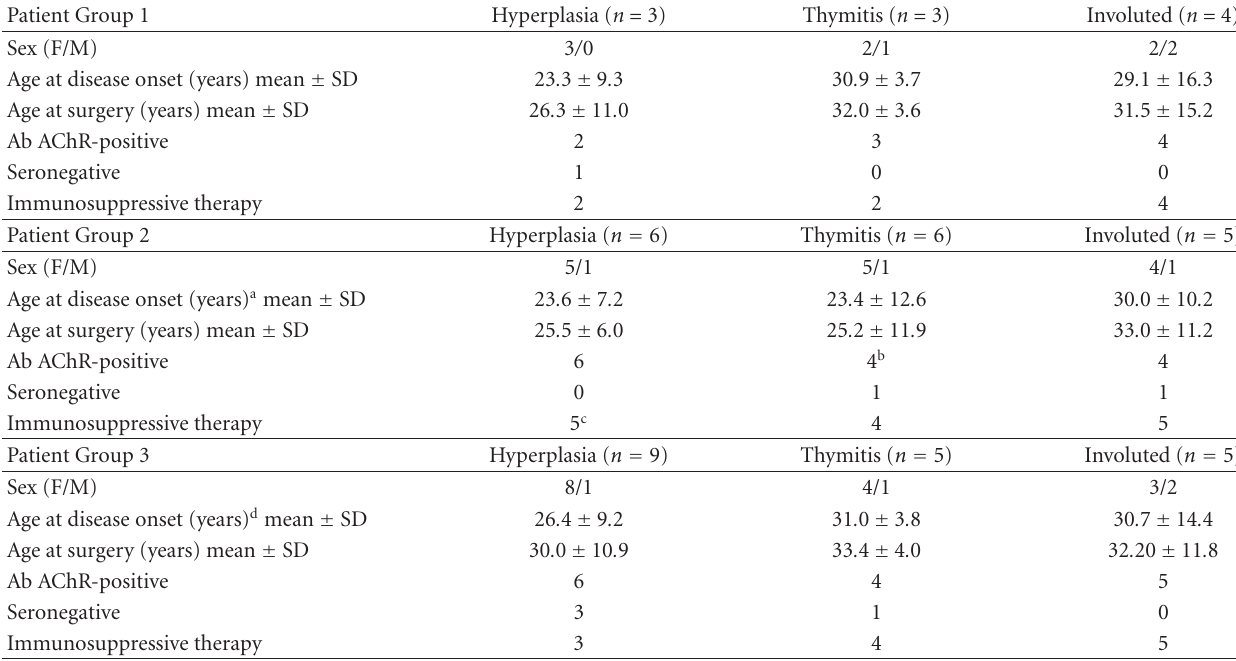
Table 1: Clinical features of MG patients included in the